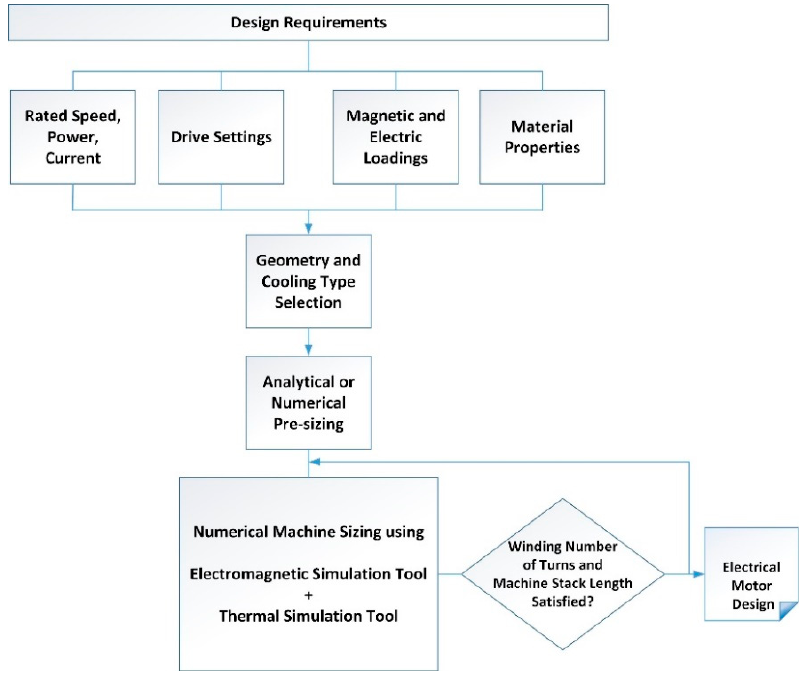
Figure 5. Flow diagram of classic sizing methodology used in the designing of electric motors.